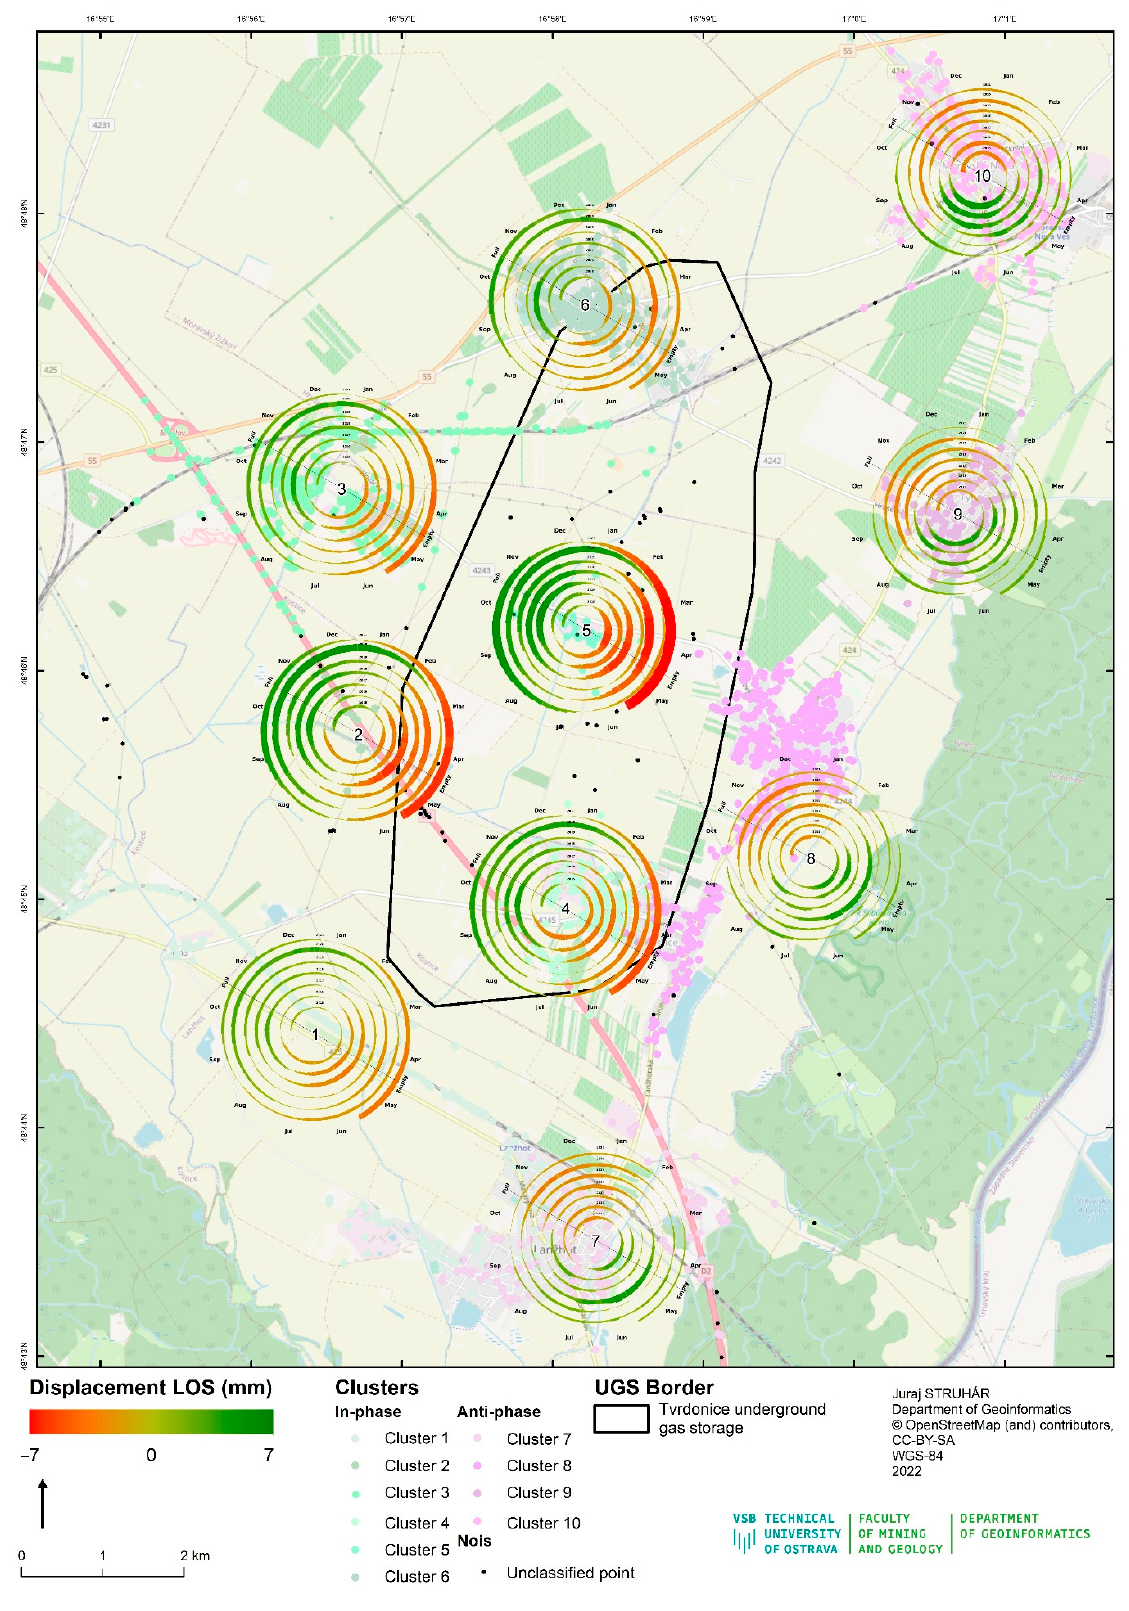
Figure A7. Map composition depicting the distribution of spiral graphs over cluster centroids in the form of the diagram map using smoothed data.